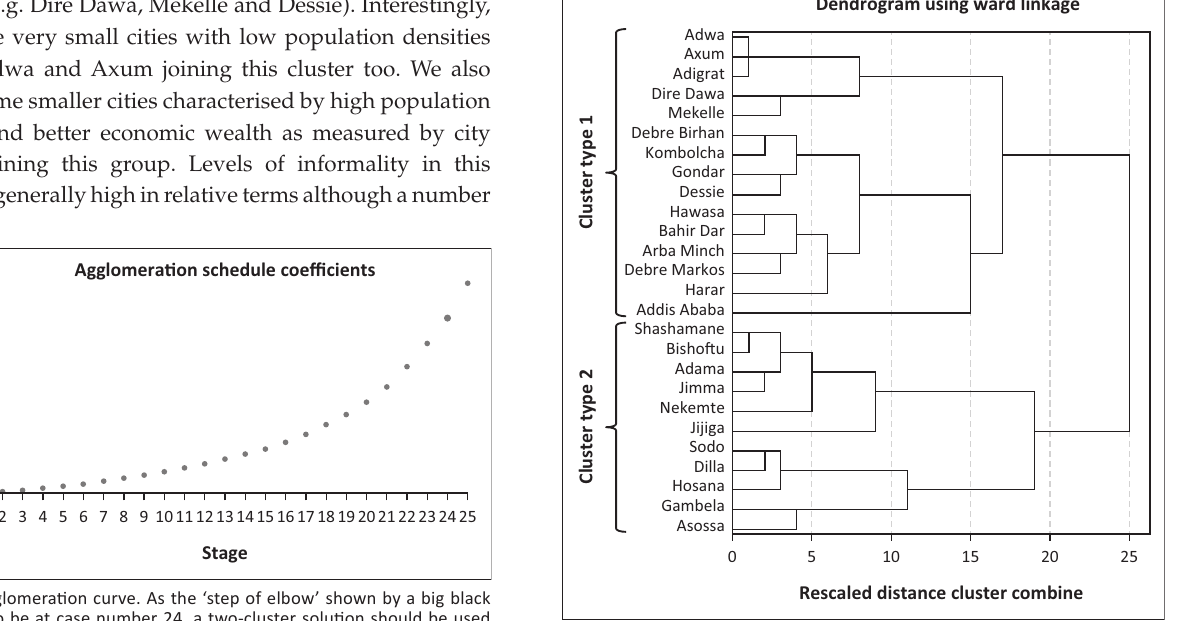
FIGURE 6: Dendrogram indicating two clusters of cities and